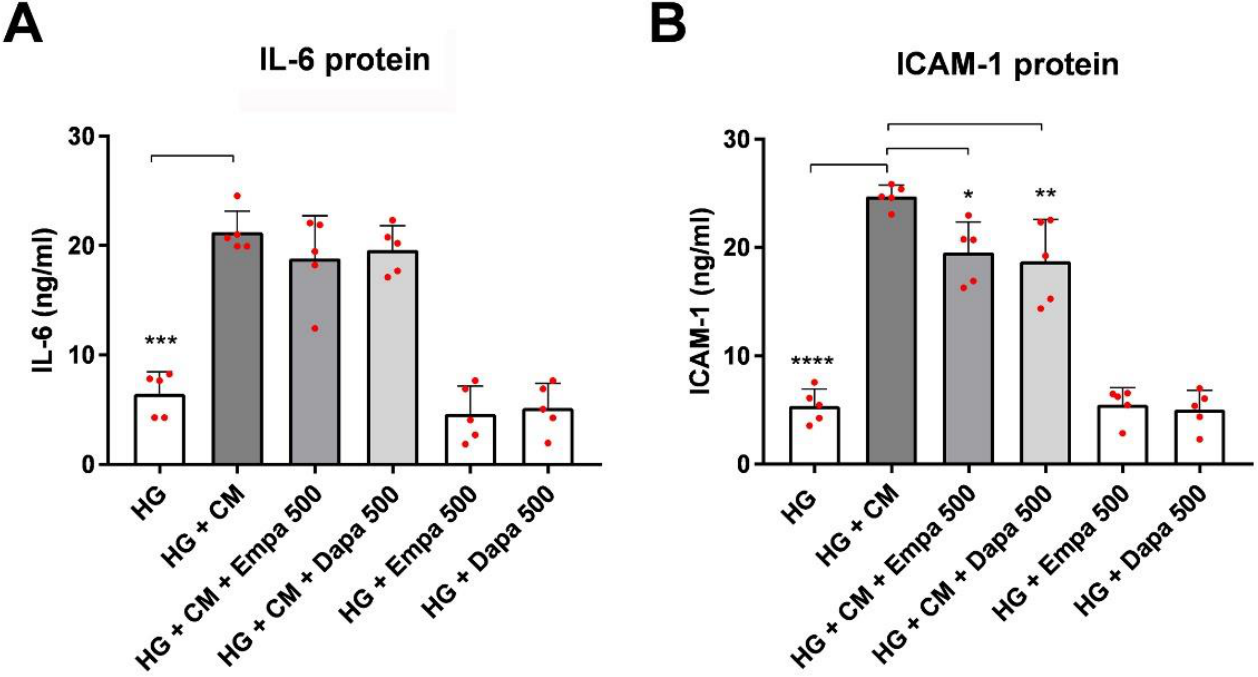
Figure 4. Effect of empagliflozin and dapagliflozin on the release of ( A ) IL-6 and ( B ) ICAM-1 protein. Cells were grown in a 24-well plate until confluence, serum depleted for 2 h, and cultured in the media indicated. Supernatants were then harvested and quantified using commercially available immunoassays (optical density 450/620 nm, scatter plots with mean ± SD). ( A ) *** p < 0.01 versus HG, n = 5, ( B ) * = 0.019, ** = 0.005, **** p < 0.001, n = 5.